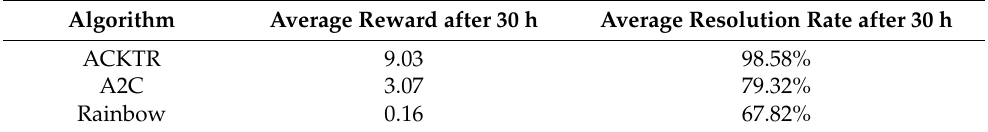
Figure 12. Training speed of ACKTR, Rainbow, and A2C on the same training set. Table 6. Training data of different algorithms.